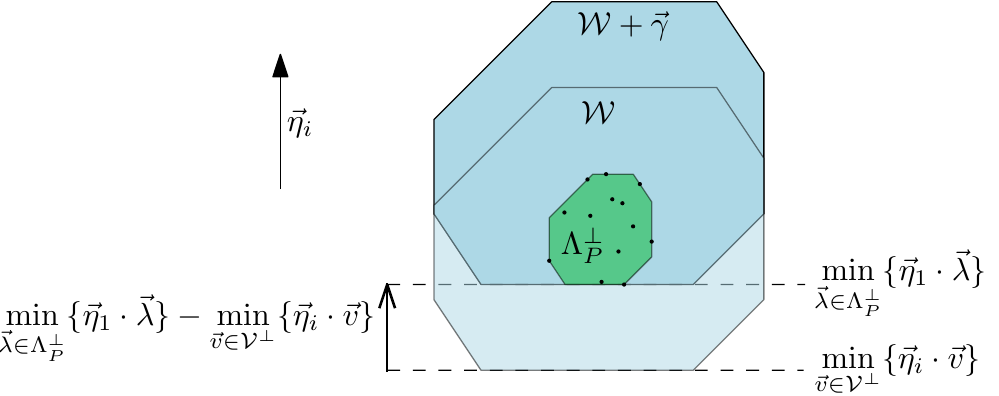
Figure 12. Illustration of the shifting of the cut-window in the direction of one of its norm